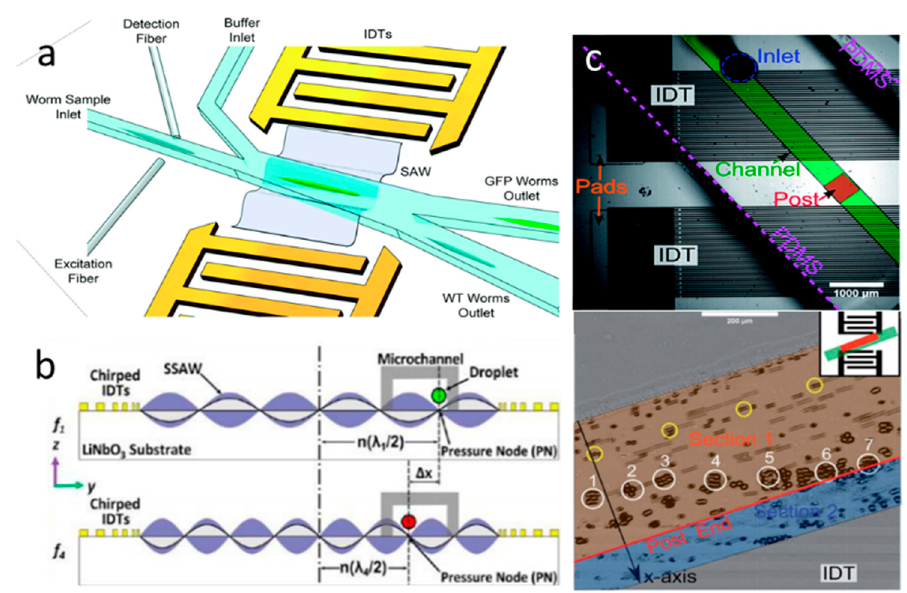
Figure 4. ( a ) Schematic illustration of an SSAW-based C. elegans sorting system. Reprinted